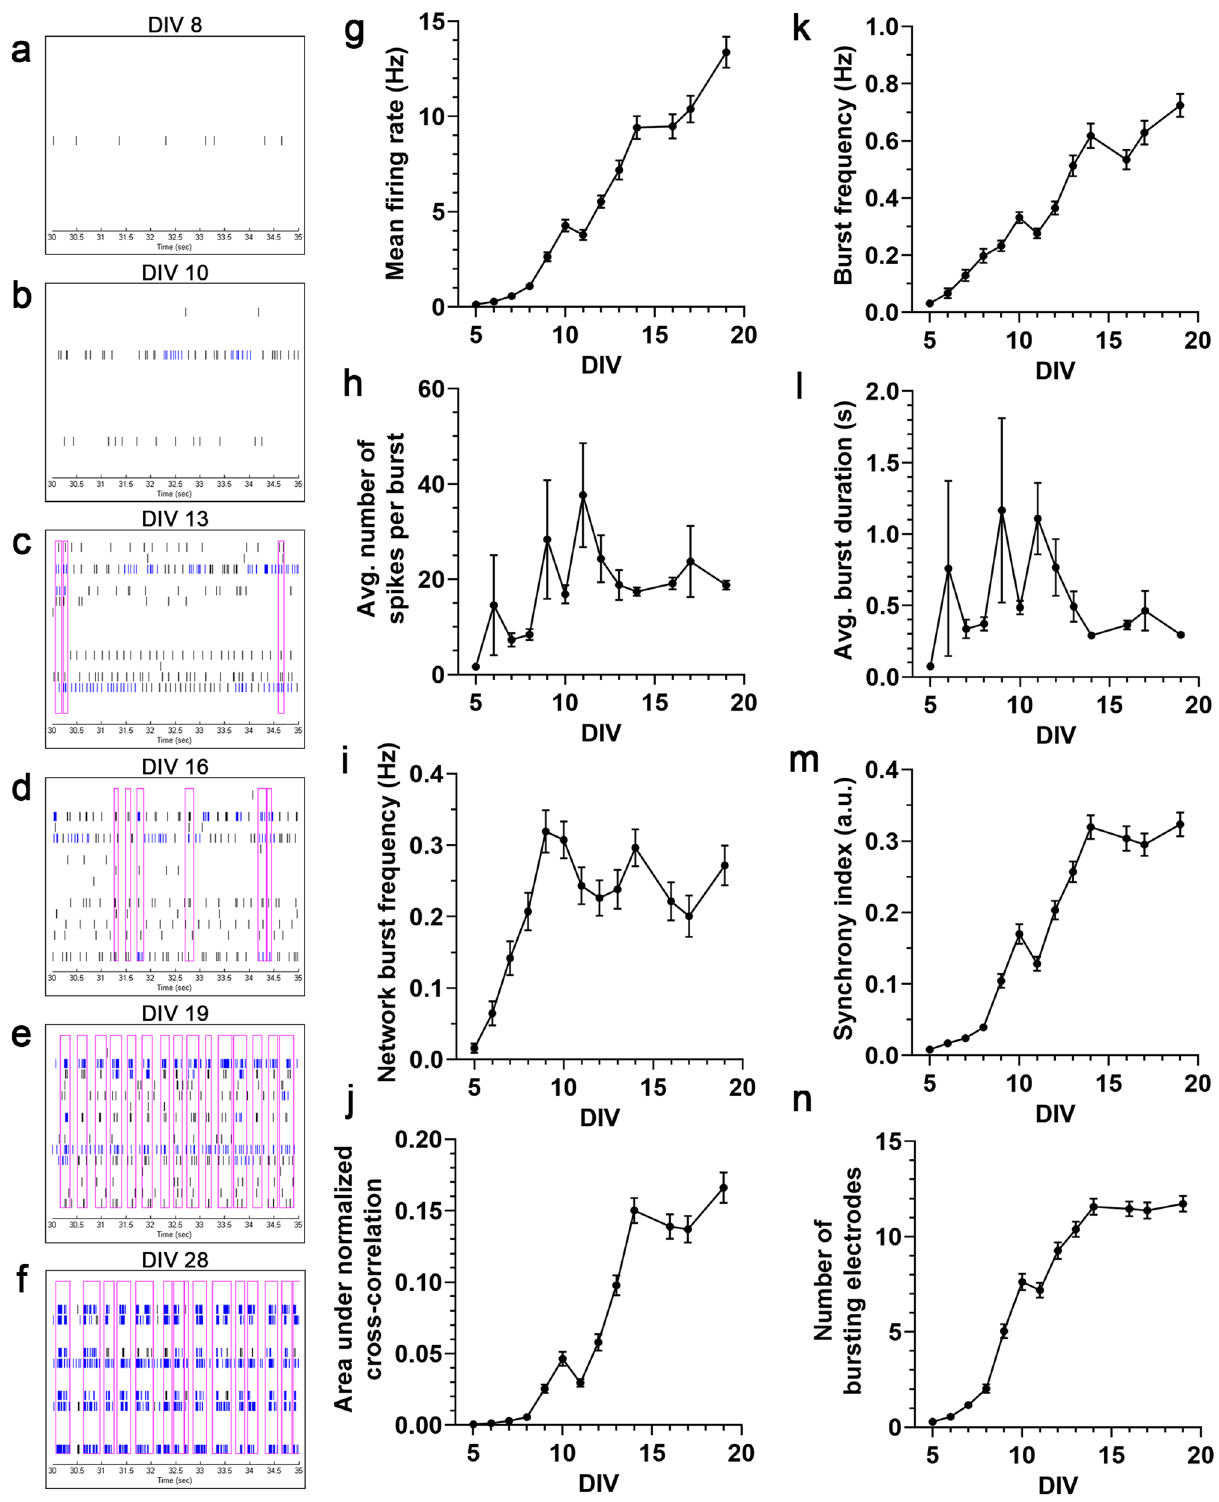
Figure 1. Neural network ontogeny revealed by microelectrode array. ( a – f ) Representative raster plots of one well over time, demonstrating qualitative network development. Each plot is 5 s for sufficient spike and burst resolution, and horizontal rows correspond to one channel/electrode, each. Note the changes over time: few spikes on few channels (DIV 8) to more spikes on more channels (DIV 10) to sporadic bursts (DIV 13, 16) to rhythmic network bursts (DIV 19) to stronger, rhythmic network bursts (DIV 28). ( g – n ) Line graphs of 8 example individual MEA parameters covering major categories (activity, bursting, network bursting, synchrony). Raster plots generated with Neural Metric Tool v1.2.3 software (Axion Biosystems): https:// www. axion biosy stems. com/ produ cts/ softw are/ neural- module# appli catio